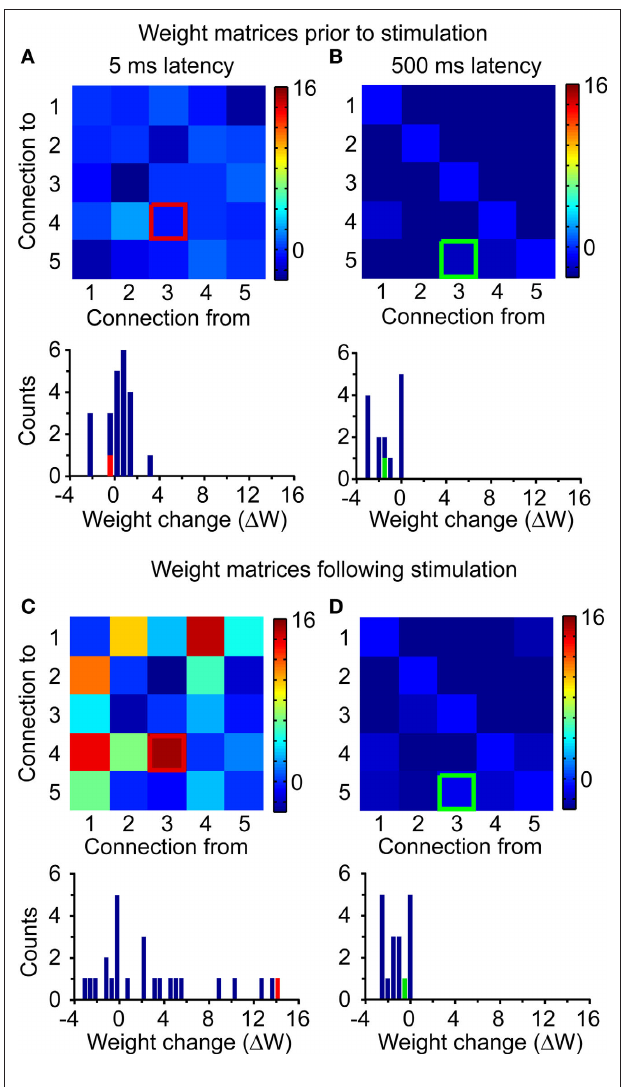
Figure 7 | Network-wide potentiation effects. Matrix of connectivity changes ∆ W for the two stimulation experiments of Figure 3 . In all plots, the trigger-to-target connection is highlighted. (A) ∆ W matrix and histogram for the period from − 24 to 0 h for the 5-ms latency stimulation. (B) Corresponding results for the period from − 24 to 0 h for the 500-ms latency stimulation. (C) Results for the period from 0 to 48 h after the onset of stimulation at 5-ms latency. (D) Corresponding results for the period from 0 to 48 h after the onset of stimulation at 500-ms latency.